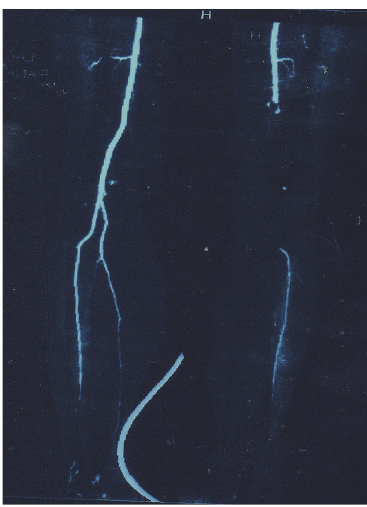
Figure 3: Thromboembolism leading to occlusion of the right popliteal